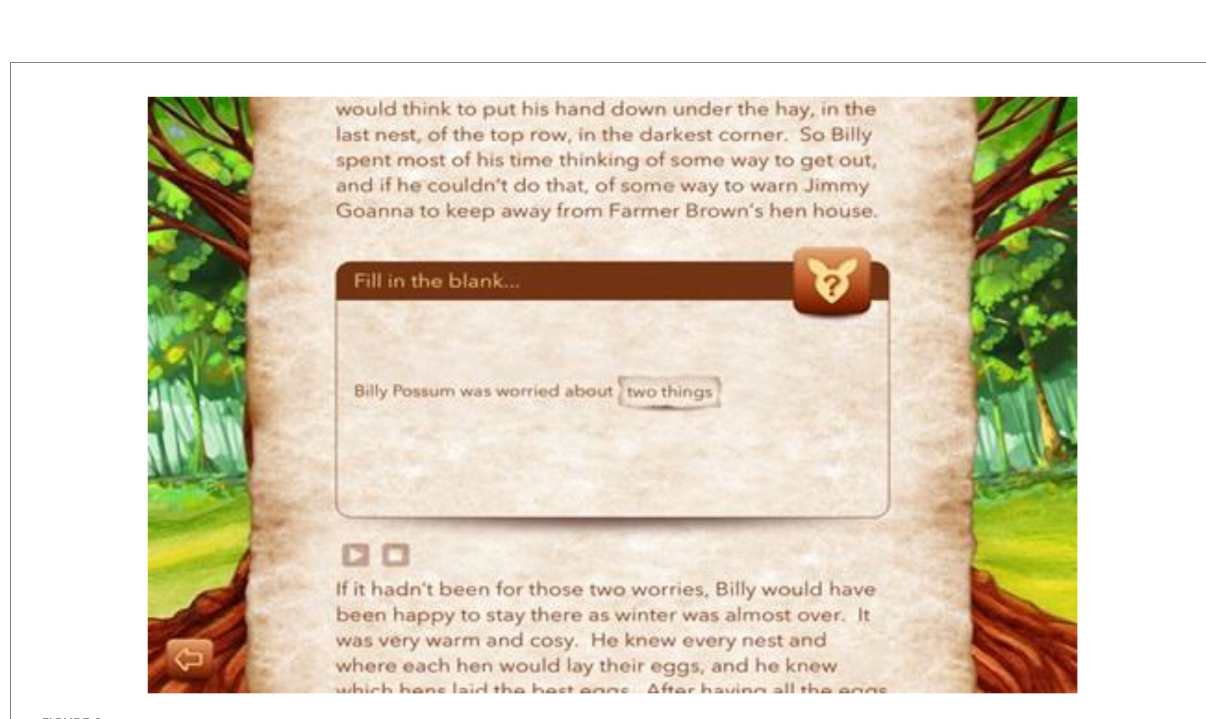
FIGURE 6 Screen shot in app of correct response and release of following